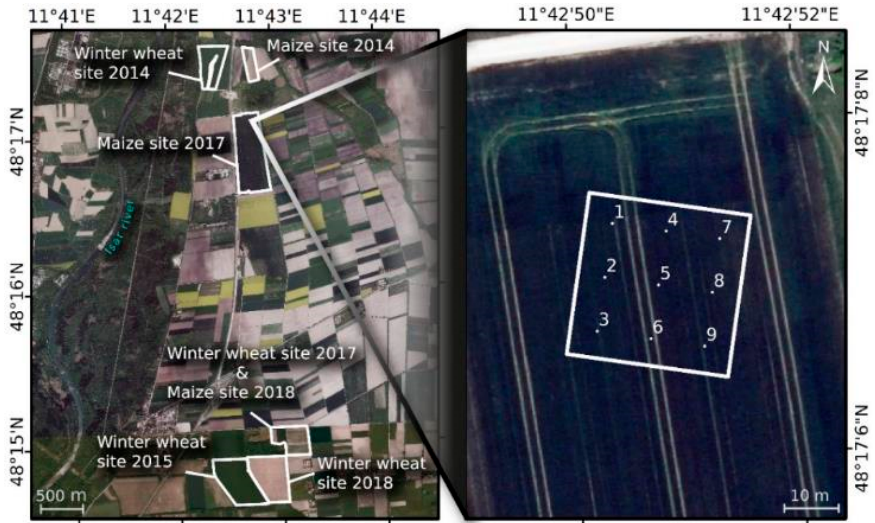
Figure 1. Overview of the study site Munich North Isar with its test fields for winter wheat and silage maize in the years from 2014 to 2018 (left). The image on the right shows the layout of the measurement design for the nine sampling units per field. Reference system: WGS84 (EPSG 4326). Table 2. List of field campaigns at the MNI study site in southern Germany.